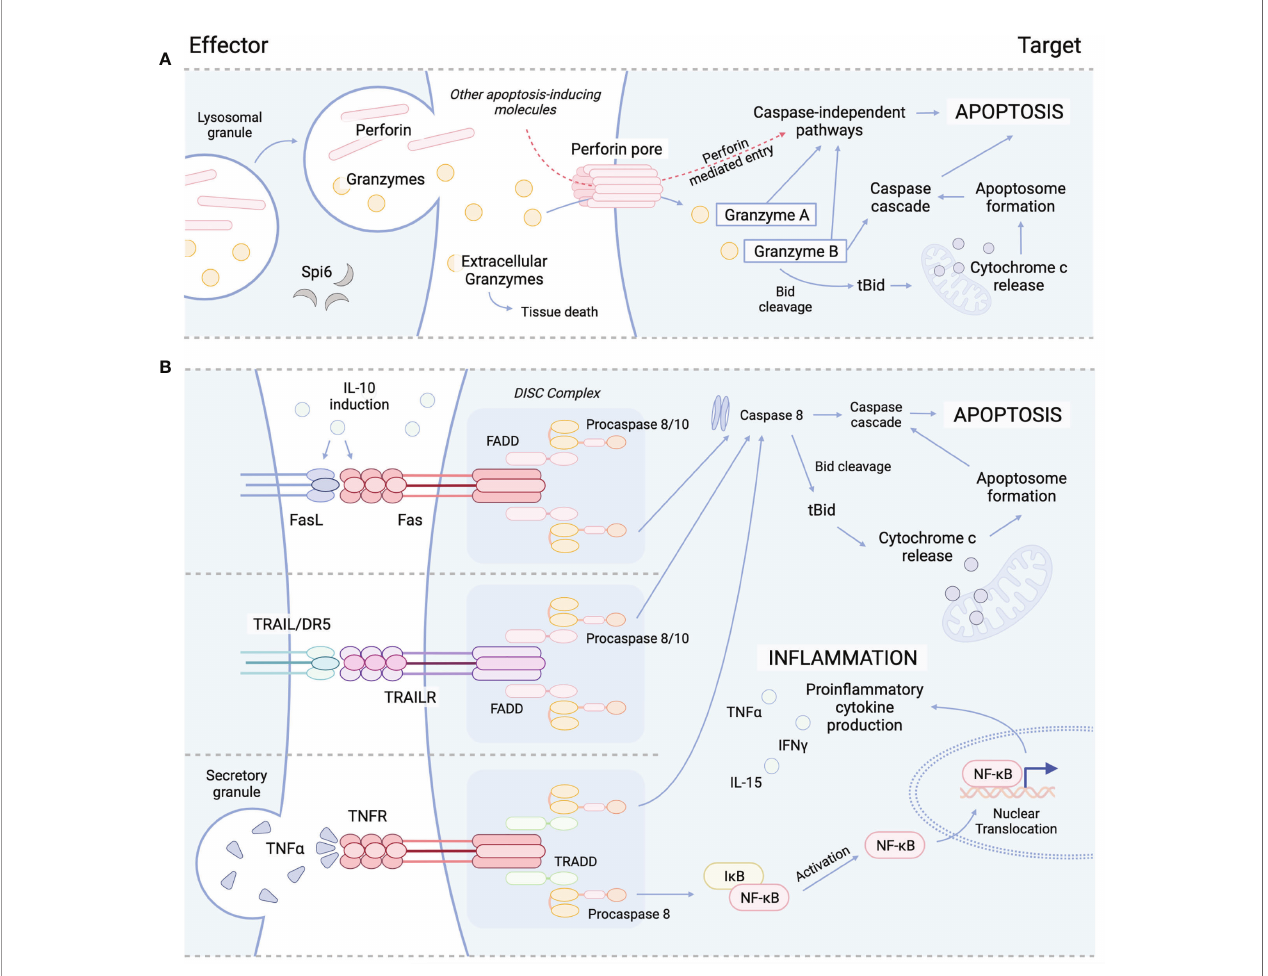
FIGURE 1 | Cytolytic mechanisms utilized by cyTreg to modulate immune responses. (A) Granzyme perforin pathway. (B) Fas/FasL pathway (top), TRAIL/TRAILR pathway (middle), TNF a /TNFR pathway (bottom). Spi6, Serpin protease inhibitor 6; TRAIL, tumor necrosis factor-related apoptosis-inducing ligand; TRAILR, tumor necrosis factor-related apoptosis-inducing ligand receptor; DR5, death receptor; TNF a , tumor necrosis factor alpha; TNFR, TNFR, tumor necrosis factor receptor; Bid, BH3 interacting-domain death agonist; tBid, truncated Bid; FADD, Fas-associated protein with death domain; TRADD, TNFRSF1A associated via death domain; NF-kB, nuclear factor kappa B; DISC, death-inducing signaling